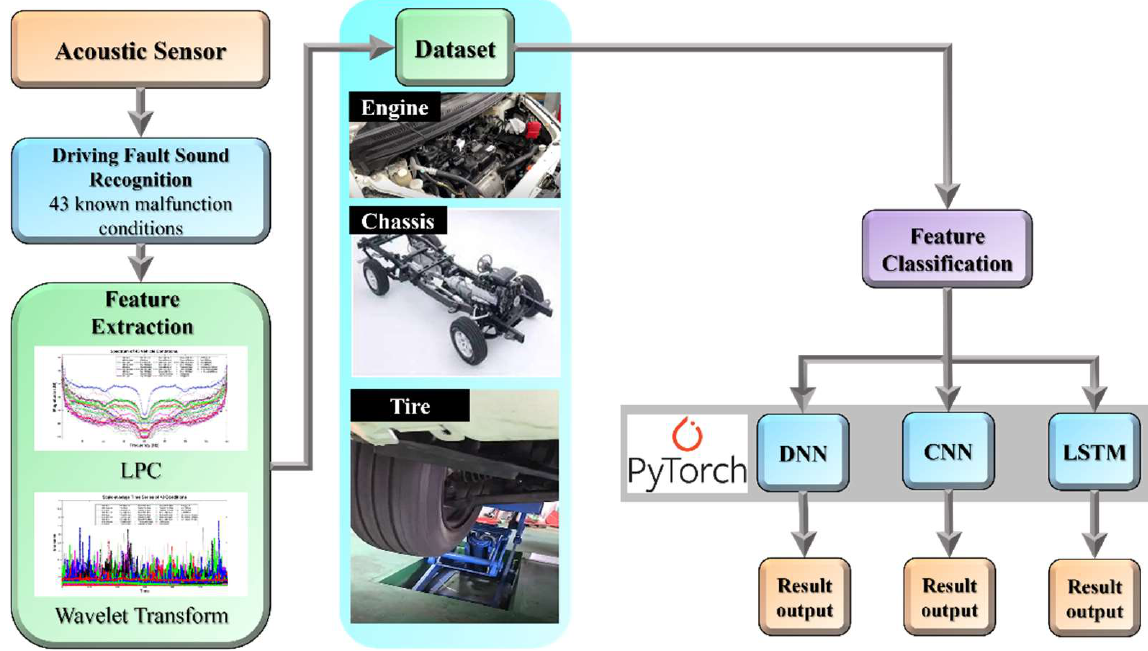
Figure 8. Systematically experimental structure with the use of classifying methodology for a driving fault acoustic signal system. Table 1. The definition of 43 driving fault signals (engine, tire, and chassis).